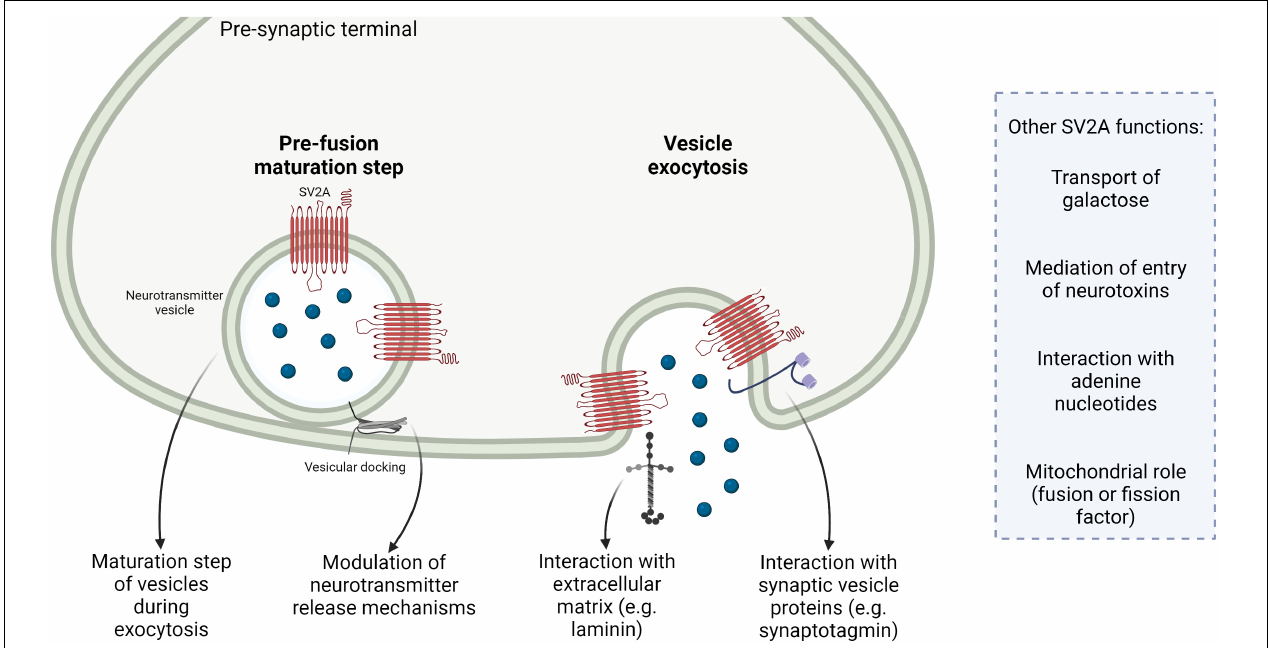
FIGURE 1 | Summary of the main putative roles of the isoform synaptic vesicle glycoprotein 2A (SV2A). SV2A participates in a pre-fusion maturation step during vesicular exocytosis; SV2A is involved in neurotransmission via multiple mechanisms, e.g., by modulating the coupling between calcium entry and neurotransmitter release or by regulating machinery involved in neurotransmitter release; SV2A interacts with extracellular matrix components, e.g., laminin; SV2A interacts with other synaptic vesicle proteins, such as the calcium-sensor synaptotagmin. Other SV2A possible functions are reported, for example the transport of galactose, mediation of vesicular entry of neurotoxins, interaction with adenine nucleotides and mitochondrial localization and role as fusion or fission